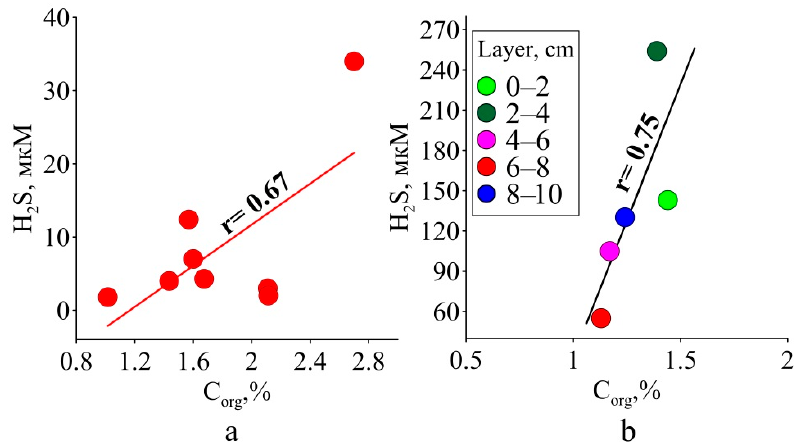
Figure 10. Relationship between H 2 S concentrations in pore water and C org in: ( a ) 0–5 cm layer and ( b ) bottom sediment cores.